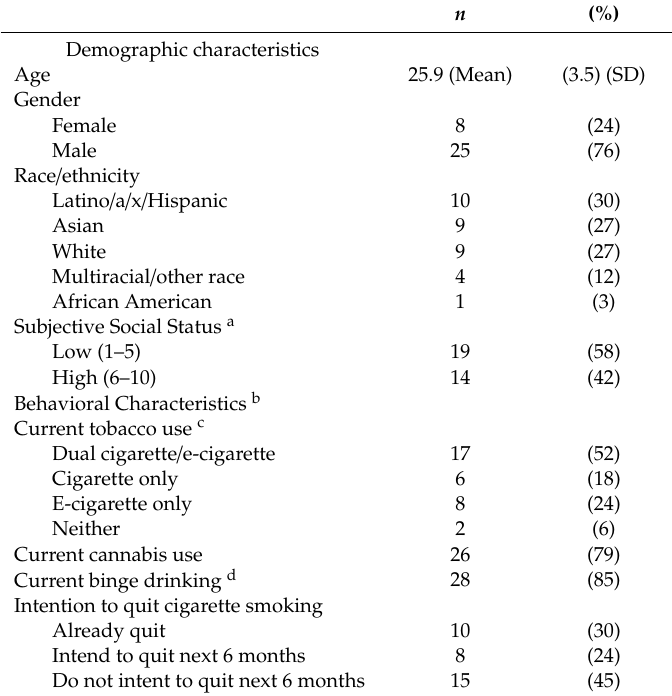
Table 1. Sample sociodemographic and behavioral characteristics ( n =